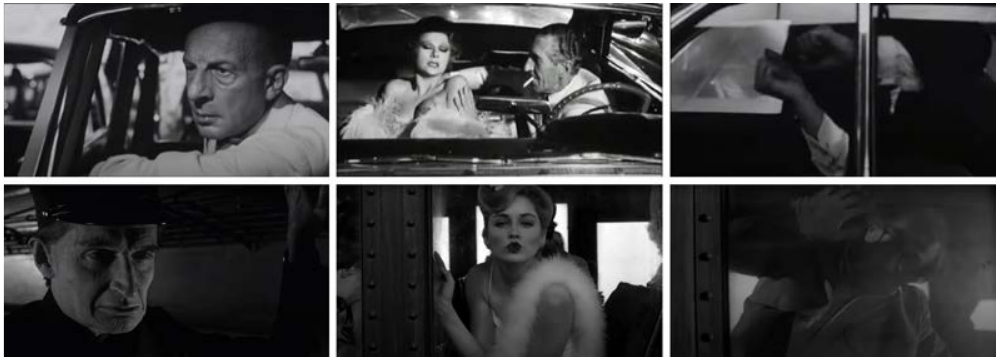
Fig. 7 Federico Fellini, 8 ½ , 1963 (above); Woody Allen, Stardust Memories , 1980